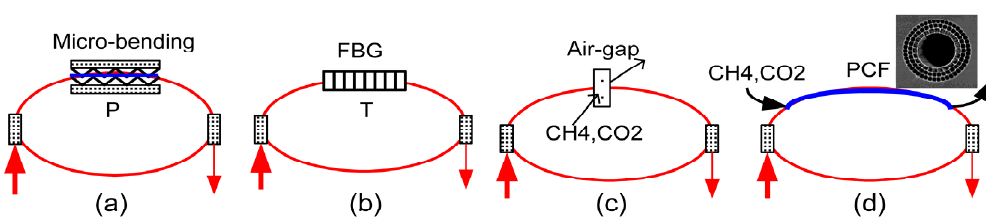
Figure 6. Configurations of different sensor